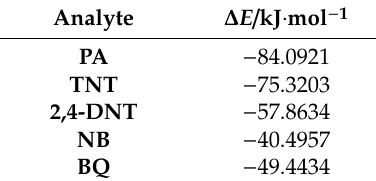
Table 2. Binding energy ( ∆ E ) in gas-phase for the complexation between Model-Calix-2-CBZ and various analytes 1 .